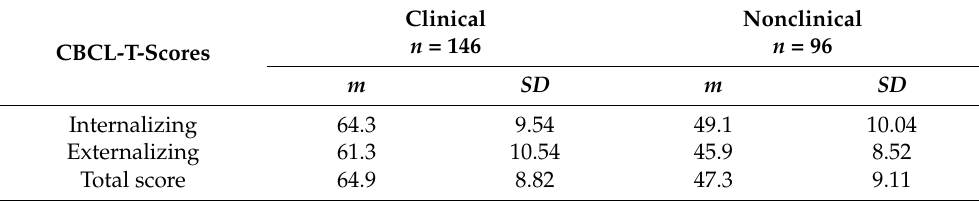
Nonclinical n = 96